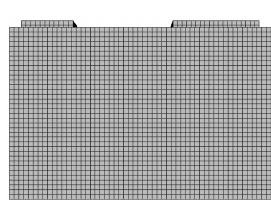
Figure 1. Single battery grid meshing